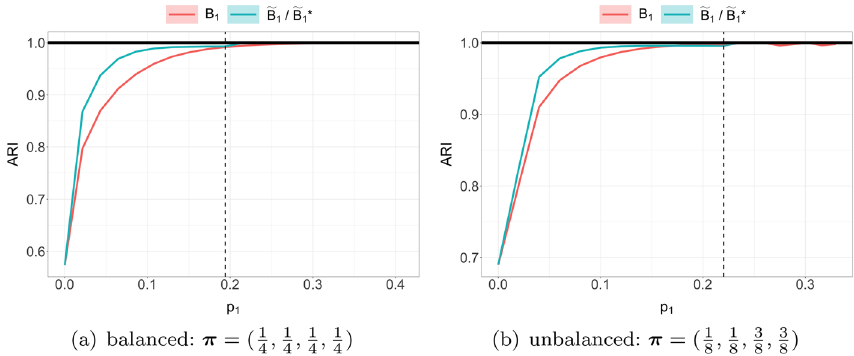
Fig. 4 Simulations for 4-block SBM parameterized by block connectivity probability matrix B as in Eq. (14) with initial sampling parameter p 0 p max 11 is defined as in Eq. (22). The dashed lines denote p ∗ 1 which is defined as in Assumption 2